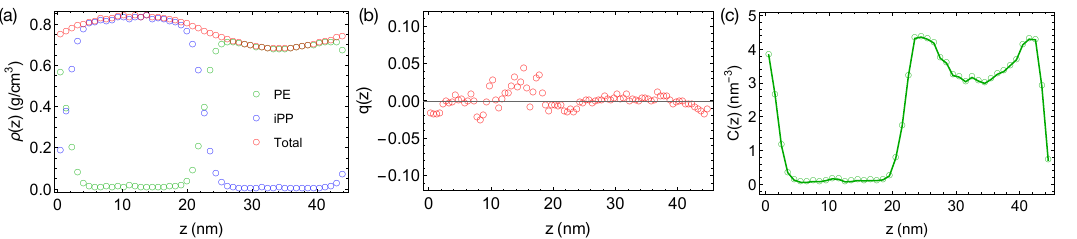
Figure 3. ( a ) Density profiles; ( b ) distribution of nematic order; ( c ) concentration of all-trans PE atoms in the binary blend of PE/iPP oligomers simulated using LINCS and a time step of 4 fs at 450